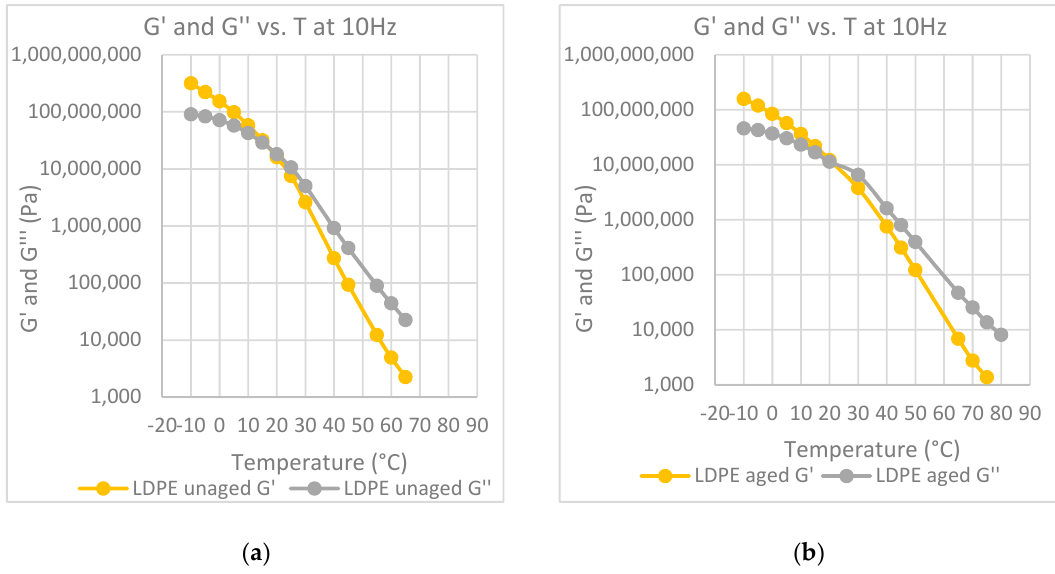
Figure 7. Elastic modulus, G ′ and loss modulus, G ′′ , at 10 Hz, as a function of temperature: ( a ) binder modified with LDPE before aging; ( b ) binder modified with LDPE after aging at the RTFOT.